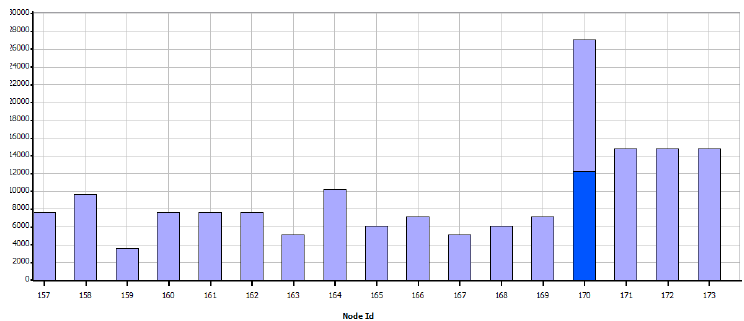
Figure 9. Total data (bytes) sent per